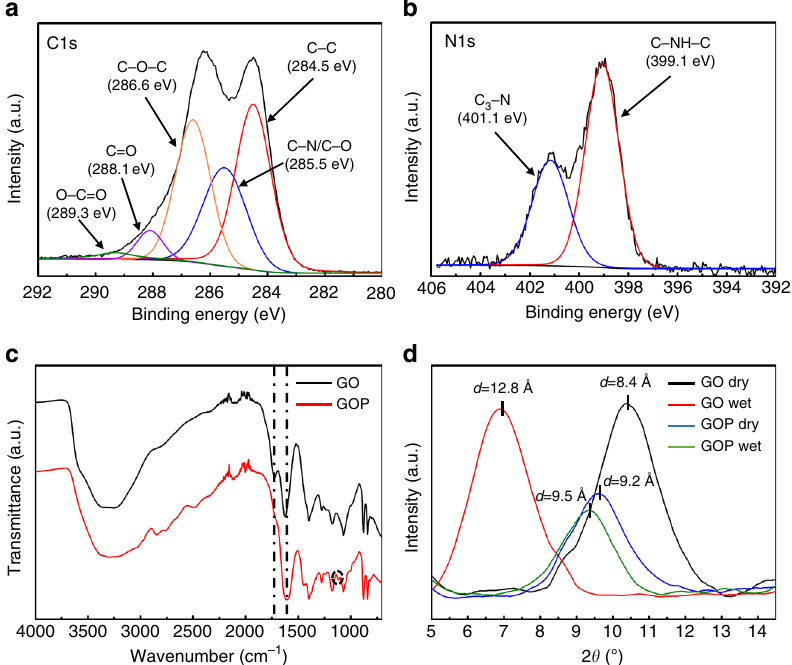
Fig. 3 Characterization of surface functional groups of GO and GOP membranes. XPS spectra of GOP membrane in C 1s region ( a ) and N 1s region ( b ); c ATR-FTIR spectra of GO and GOP membranes, showing the new carbon-nitrogen peak appeared and the original carboxyl and carbon double bond shifted; d XRD patterns of GO and GOP membranes at dry and wet states, respectively, and the corresponding d